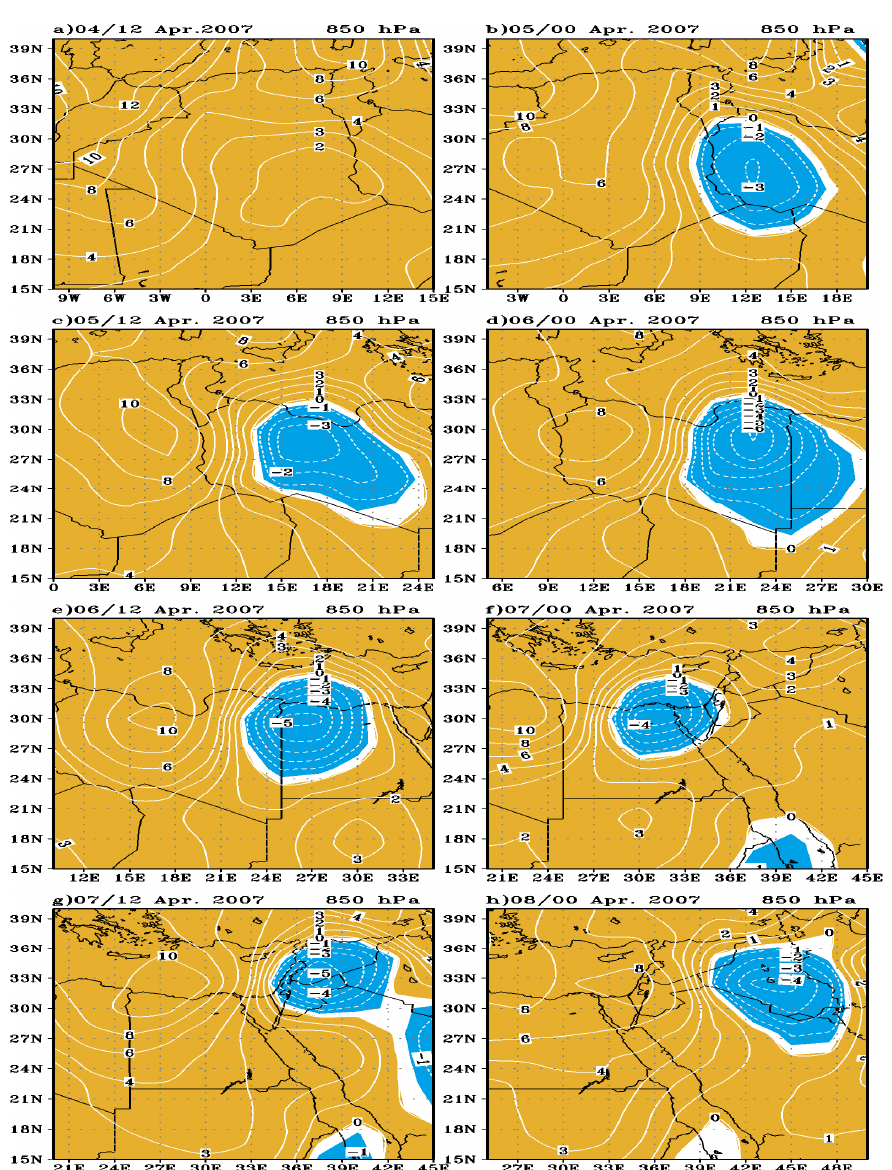
Figure 8. The 850 hPa Q vector ω fields have units of 10 − 2 Pa/s. Solid (dashed) contours represent subsidence (rising motion) at 12Z and 00Z for 4–8 April 2007.